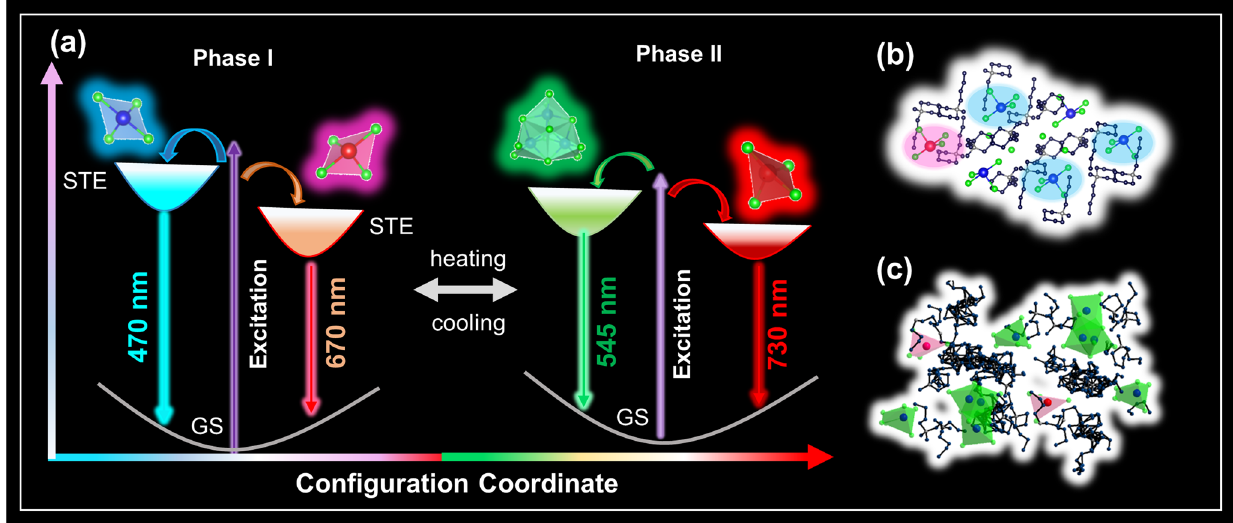
Fig. 4 Structure dependent emission properties. a Con fi guration diagrams of the phase-dependent dual emission processes in Pb-Br: Sb and the emission properties of different metal halide polyhedron units. Scheme view of ( b ) blue/red dual emissive Pb-Br: Sb (phase I) and ( c ) green-red dual emission after phase transformation (phase II).